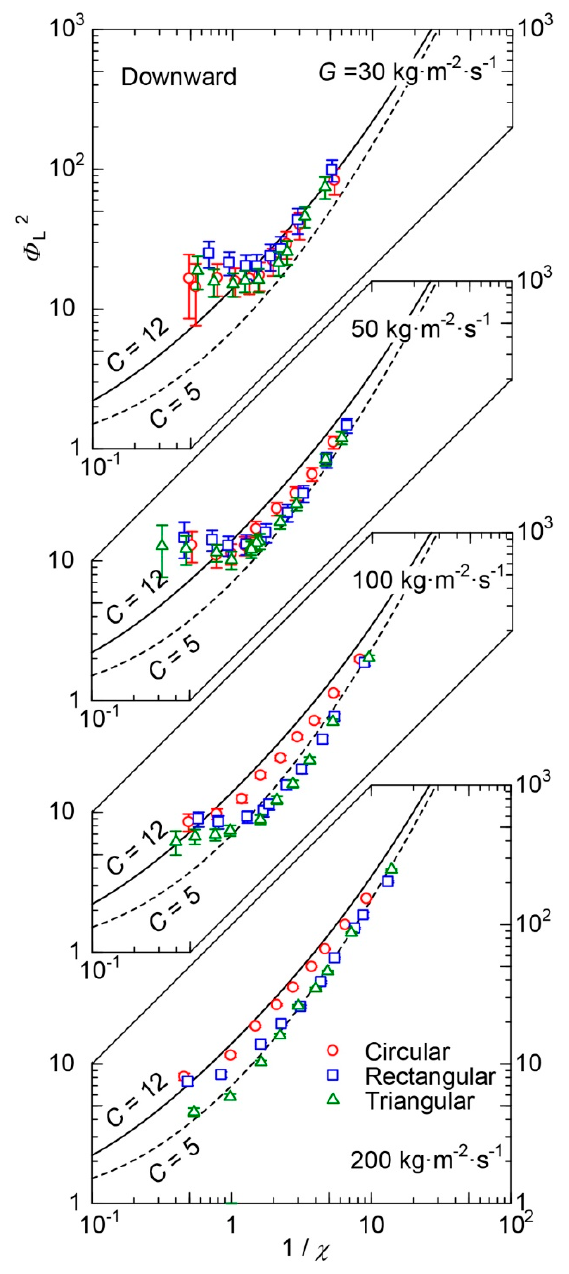
Figure 14. Two-phase frictional multiplier vs. inverse of Lockhart–Martinelli parameter flowing downward in circular, rectangular, and triangular tubes.